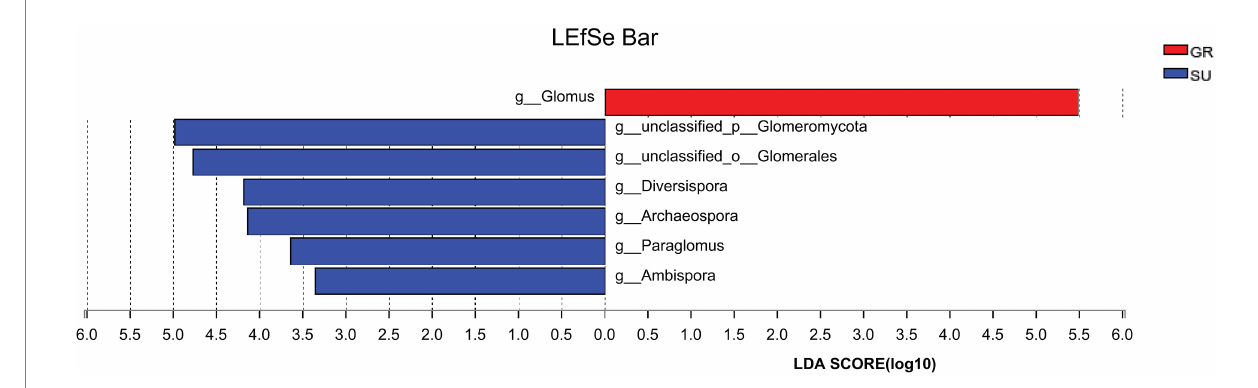
FIGURE 5 LEfSe analysis of GR and SU.